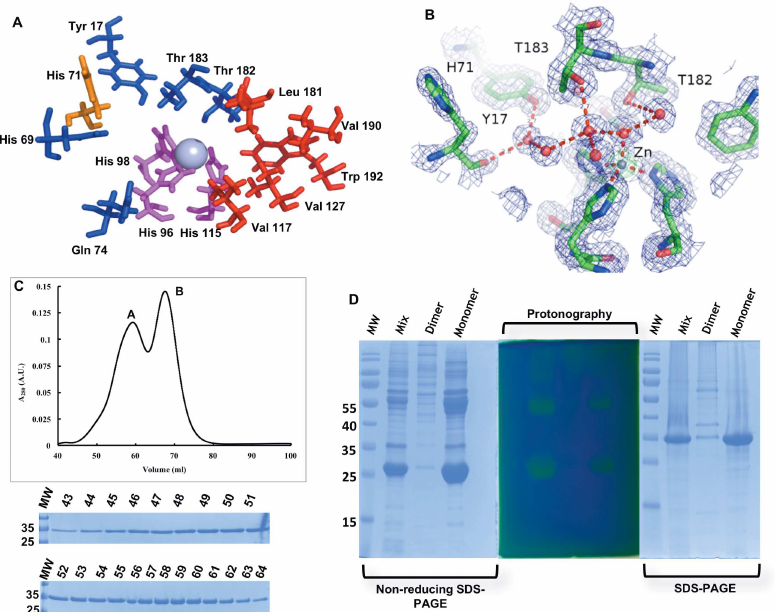
Fig 2. Cartoon representation of the PprCA active site and oligomerization status of PprCA. ( A ) The highlyconservedactive site residuesof PprCA showingZinc ion in the center of the active site (gray sphere). The hydrophobic(Val117,Val127, Leu181, Val190and Trp192), the hydrophilic (Tyr17, Asn69, Gln74, Thr182 and Thr183), and zinc coordinating residues(His96, His98 and His115) are similar to other well characterized α –CA’s.( B ) Active site water network involvedin proton transfer is shown as red spheres. 2Fo- Fc electron density contoured at 8.0 σ (green)and 1.0 σ in blue. ( C ) Purified PprCA was analyzedon a Hiprep 16/60 SephacrylS-200 size-exclusion column that was equilibratedwith 20 mM Tris pH 7.5 and 150 mM NaCl. Peaks A and B correspond to dimer and monomer, respectively. The elution fractions were analyzedby SDS-PAGE and stainedwith Coomassie Blue. A single~35 kDa band was observedfor both dimeric and monomeric PprCA. MW–Molecular-weightmarker, lanes 43 to 51 (elutionfractions representing PprCA dimer) and lanes 52 to 64 (elutionfractions representingPprCA monomer). ( D ) Purified PprCA was separated under both reducing and non-reducing conditions on a SDS-PAGE. Laneswere loadedwith PprCA from monomerfraction, dimer fraction and from a sample containing a mixture of monomers and dimers. The gels were stained either by Coomassie blue or subjectedto protonography. Protonography was performed accordingto De Luca et al, 2015 [9]. The gel was incubatedin CO 2 enrichedwater for 5 to 15 seconds at room temperature. Appearanceof distinctive yellow bands in gels subjectedto protonography indicatesboth monomeric (~27 kDa) and dimeric (~58 kDa) PprCA is catalytically